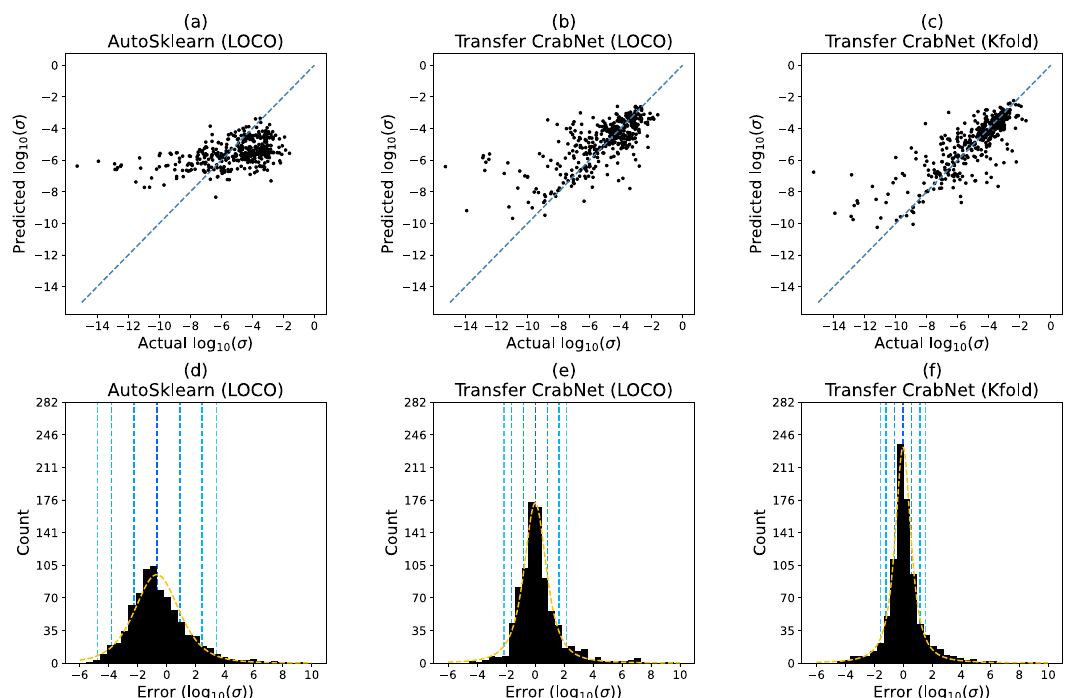
Fig. 6 Parity plots and error distributions for three regression models. AutoSklearn models assessed under LOCO-CV ( a ), ( d ) share the most similarity to the controls in Fig. 5, and are thus judged to be the least effective ML model under investigation. Under LOCO-CV, CrabNet models with transfer learning offer improved performance, which can be visually con fi rmed by the spread of points falling closer to the leading diagonal ( b ), and the distribution of errors being centred around 0 with a smaller standard deviation ( e ). ML models give a tighter distribution of errors when validated with k-folds, with transfer learned CrabNets possessing the most favourable actual vs. true characteristics ( c ) and distribution of errors ( f